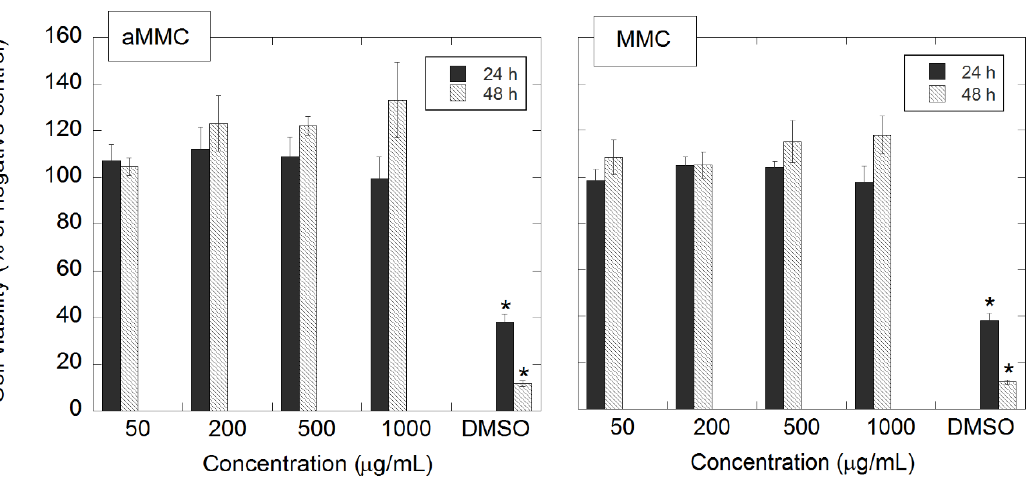
Figure 6. Cell viability of hDF cells exposed to aMMC (left panel) and MMC (right panel) after 24 and 48 h. The error bars represent the standard error of the mean and are based on n = 6. Statistically significant differences as compared to the negative control are marked with * ( p < 0.05).